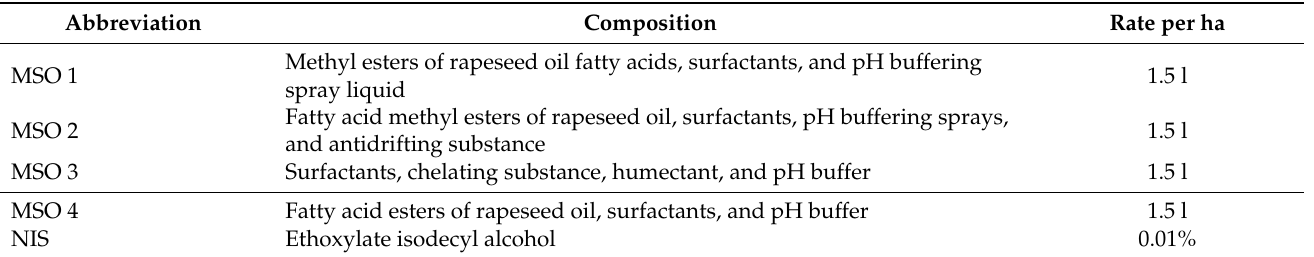
Table 5. Tested and standard adjuvants applied in the field experiments in